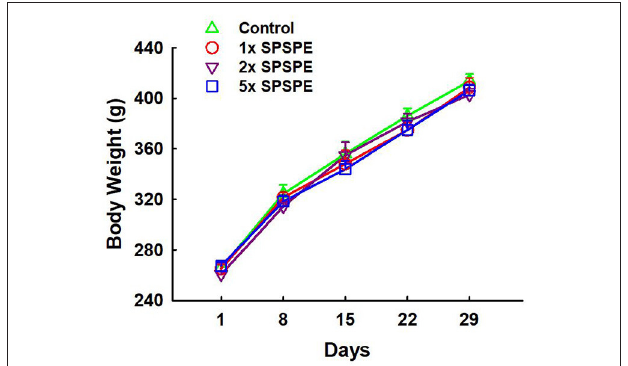
FIGURE 2 | The effects of SPSPE treatment on body weight. Each value represents Mean ± SEM, n = 9.